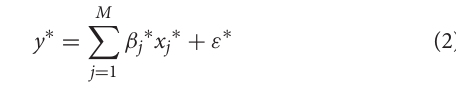
discomfort for the dwelling on the northeast façade with a 13% WWR. With the 40% WWR dwelling, there is, on average, 674 more hours of discomfort when changing the orientation of the façade from the southwest to the northeast. As discussed before, the lines for the southwest orientation (dashed lines) cross in the right-hand part of the figure for both hot and cold